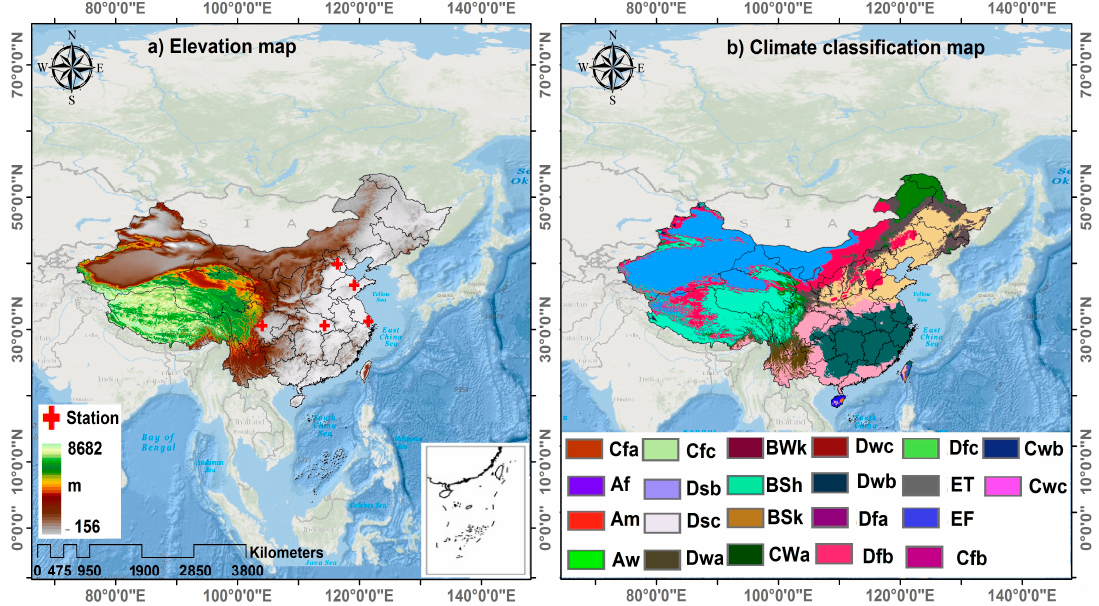
Figure 2. Study area description: ( a ) elevation map and ( b ) description of climate zones—Geiger classification in China. Main climates A: equatorial B: arid C: warm temperate D: snow E: polar Precipitation W: desert S: steppe f: fully humid s: summer dry w: winter dry m: monsoonal Temperature a: hot summer b: warm summer c: cool summer d: extremely continental h: hot arid k: cold arid F: polar frost T: polar tundra).